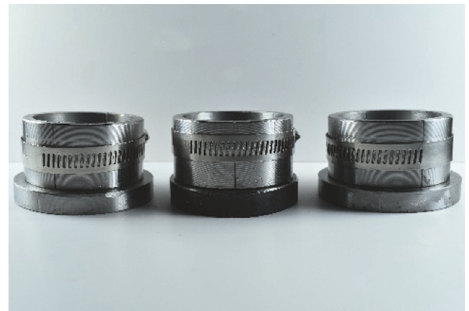
Figure 6: Custom-made mold for making specimens.